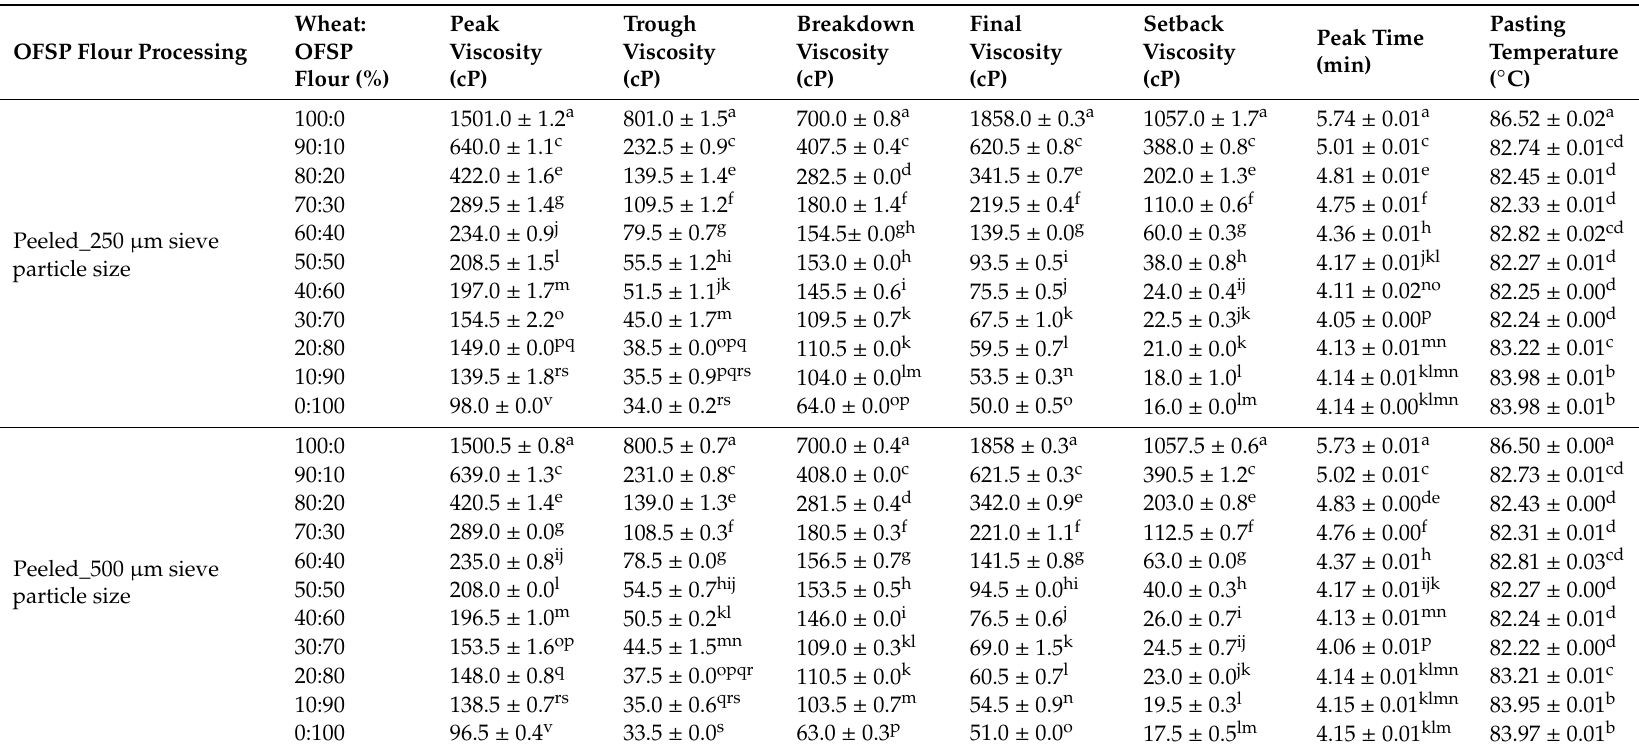
Table 4. E ff ect of sieve particle size and flour proportion on the pasting properties of peeled and unpeeled OFSP composite